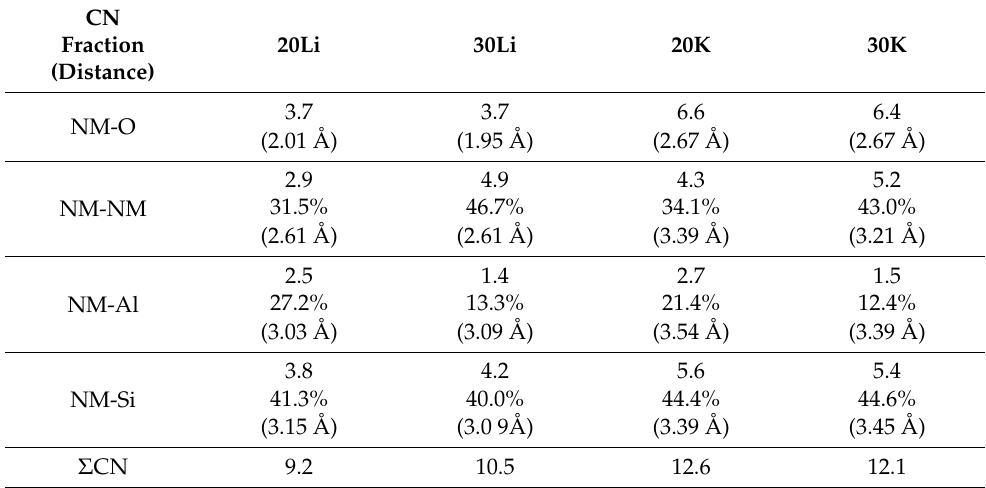
Table 3. Coordination numbers (CN) and interatomic distances of the network modifier (NM) ions in the first coordination shell (oxygen) and the second coordination shell obtained for different chemical compositions. For the second coordination shell, the fractions of the different cation coordination are additionally